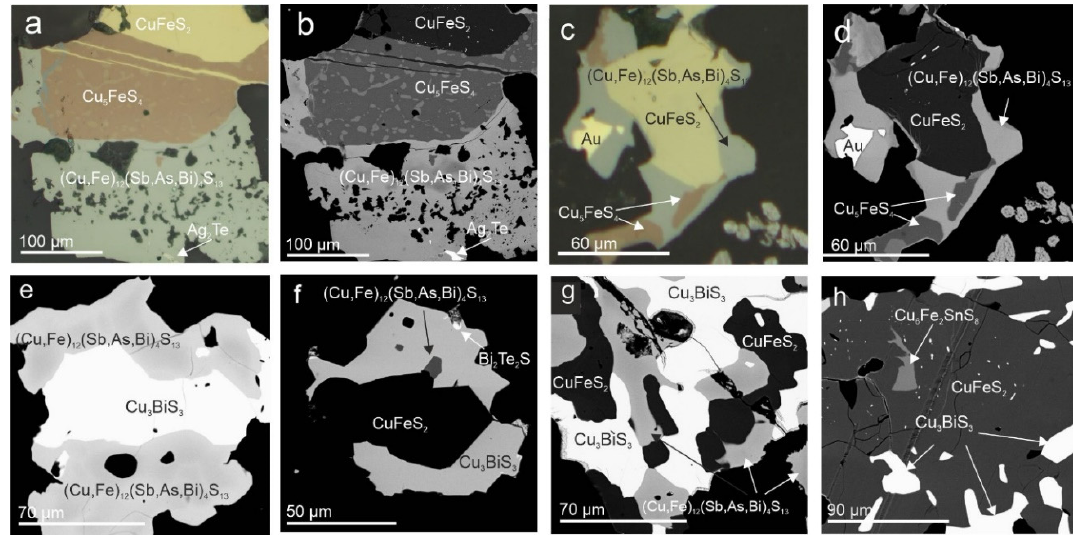
Figure 10. Microparagenesis of the gold-sulfosalt-quartz association, polished section of the Bar-2-1 sample, Rusty zone: ( a , c )—in reflected light; ( b , d – h )—SEM image. Intergrowth of chalcopyrite, bornite Cu 5 FeS 4 and tetrahedrite (Cu,Fe) 12 (Sb,As,Bi) 4 S 13 including the hessite Ag 2 Te grain; ( c , d )—Cu-bearing electrum intergrown with chalcopyrite, bornite and tetrahedrite; ( e – h ) Intergrowths of chalcopyrite with sulfosalts of different composition: tetrahedrite ( e – g ), wittichenite Cu 3 BiS 3 ( e , g – h ); tetradymite Bi 2 Te 2 S ( f ) and mawsonite Cu 6 Fe 2 SnS 8 .